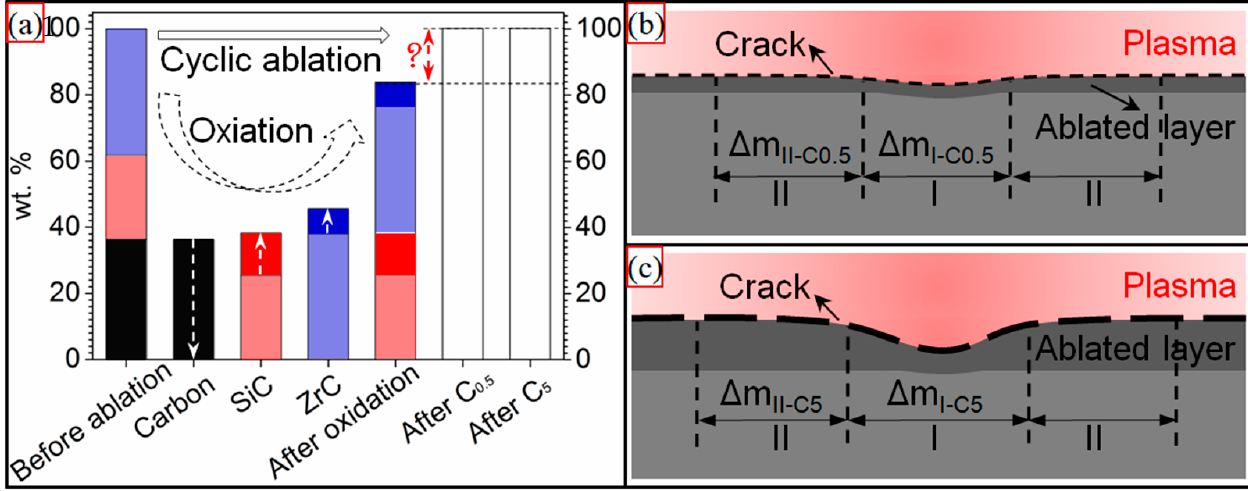
Figure 9. Schematic cyclic ablation mechanism: ( a ) mass percentage of the C/C-SiC-ZrC before and after the cyclic ablation and complete oxidation; ( b ) mass change of different ablated areas under C 0.5 ; and ( c ) mass change of different ablated areas under C 5